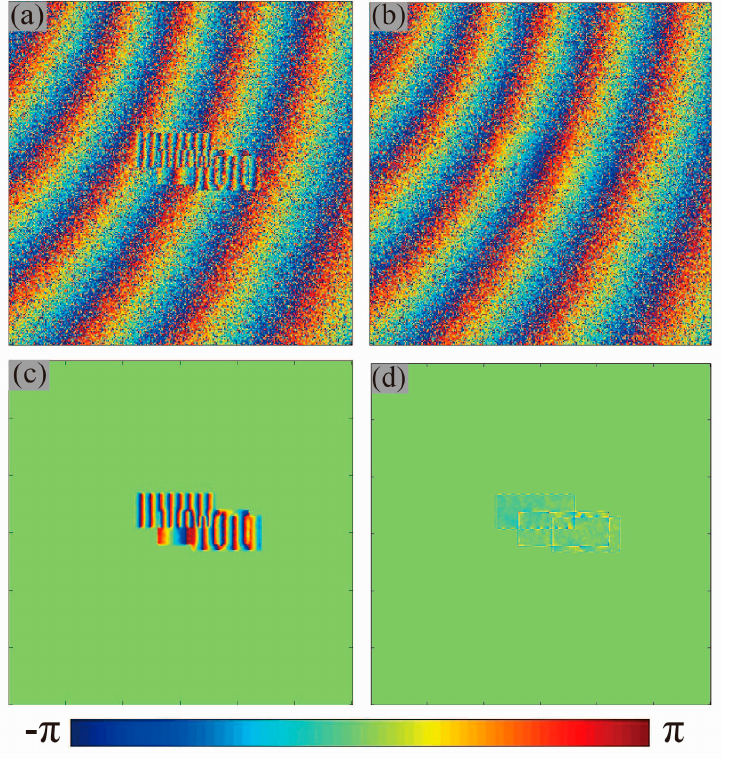
Figure 10. Result of building layover removal in simulated data: ( a ) simulated interferogram; ( b ) removal result; ( c ) extraction of overlapping phase; and ( d ) phase residual of terrain.